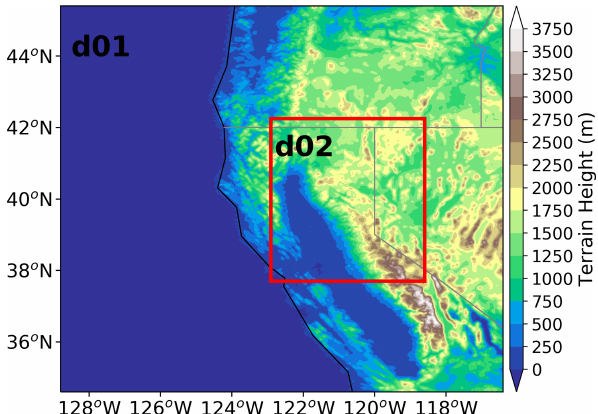
Figure 1. Two nested simulation domains: d01 and d02 centering over California. The color shading denotes the terrain